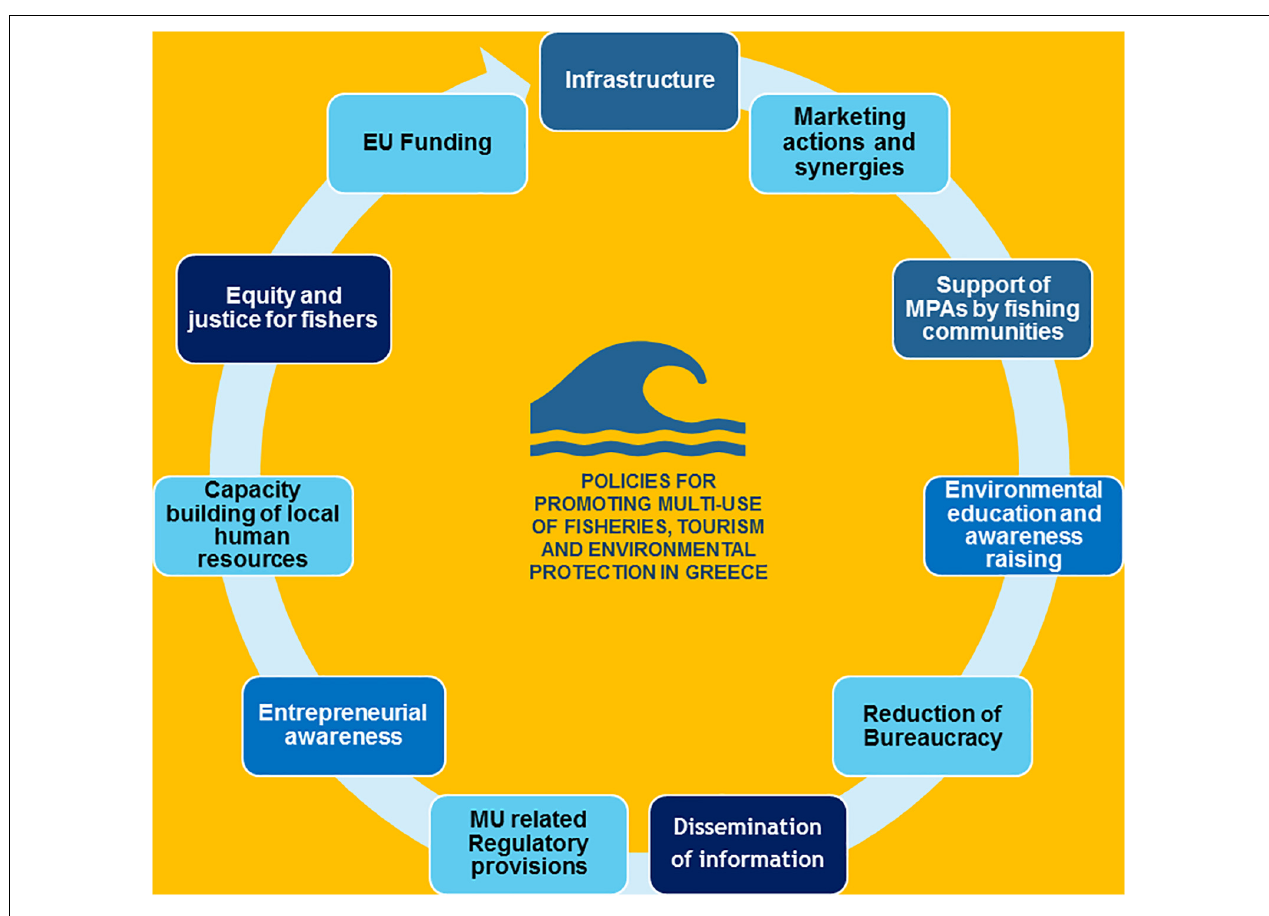
FIGURE 3 | Policy recommendations for MU of fisheries, tourism, and environmental protection in